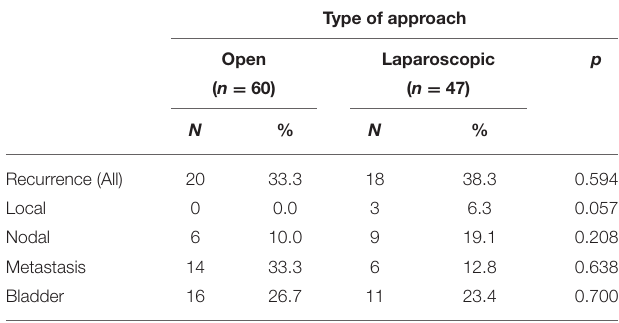
TABLE 1 | Patients’ characteristics according to surgical approach (Open vs. Laparoscopic) for Upper Urinary Tract Urothelial Cancer (UTUC) Nephroureterectomy.